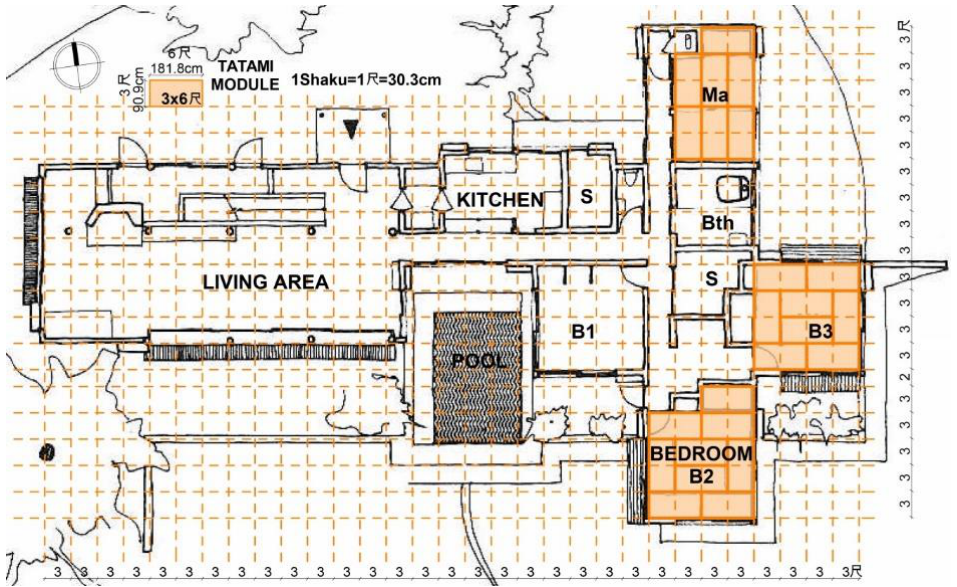
Figure 11. Karuizawa summer house — study of the tatami module over the plan.